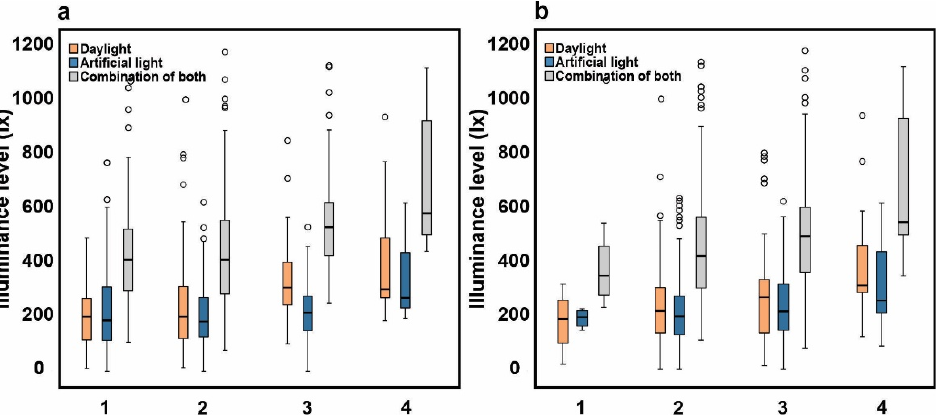
Figure 4. On-site measured illuminance in the studied buildings. Separated by WWR ( a ) separated